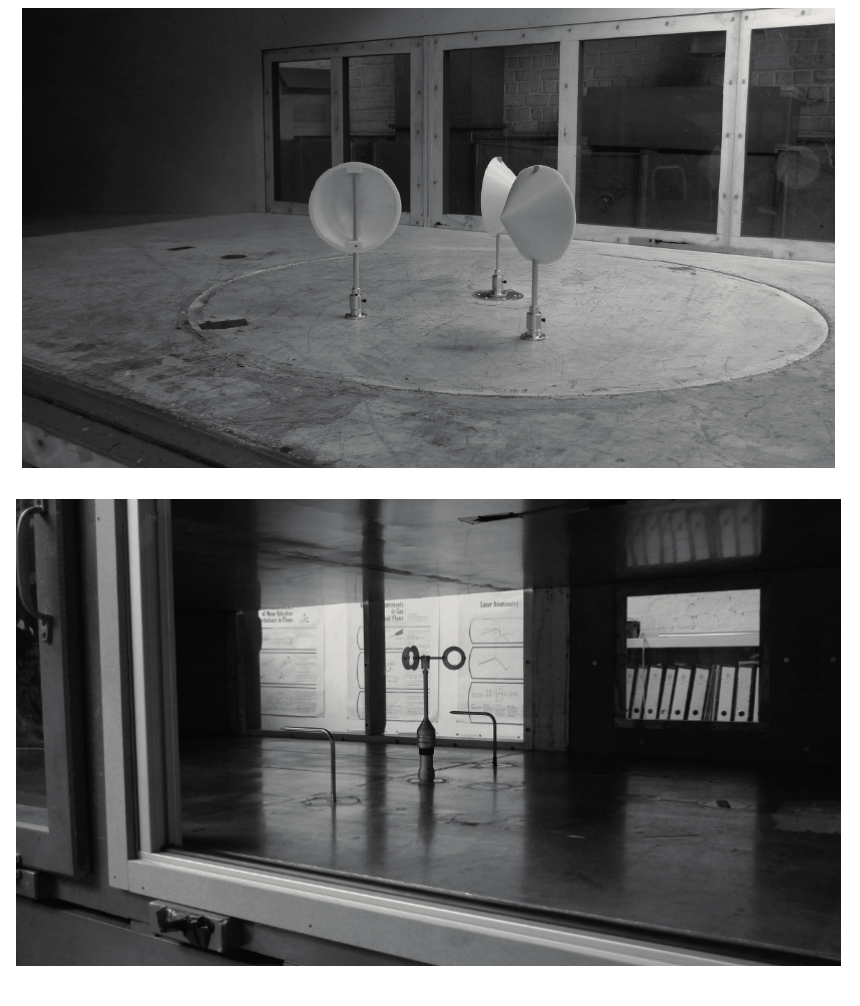
Figure 8. Wind tunnels at the Department of Mechanical Engineering at the Vrije Universiteit Brussel. ( Top ) Large wind tunnel for force measurements. The picture shows the aerodynamic force measurements on a cup in a “rotor” configuration (surrounded by two others); ( Bottom ) Anemometer calibration wind